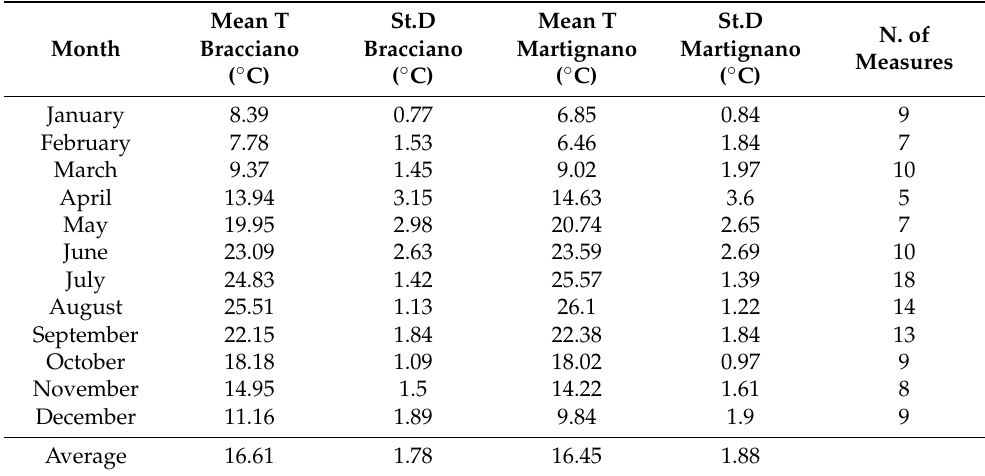
Table 7. Average year derived from Lansdat data acquired from 1984 to 2003 using our proposed approach for the atmospheric correction of Landsat data.